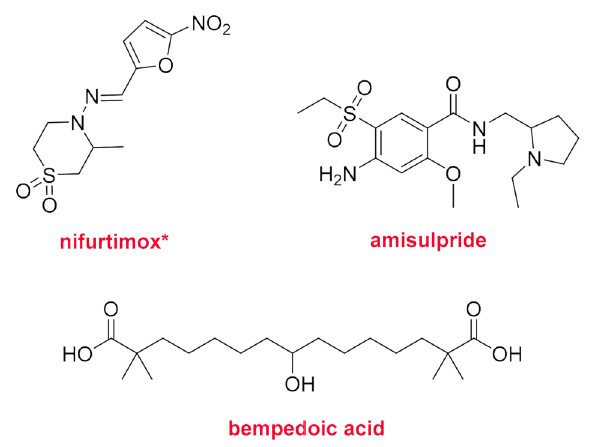
Figure 15. Structure of nifurtimox, amisulpride, and bempedoic acid. * Mixture of Z/E